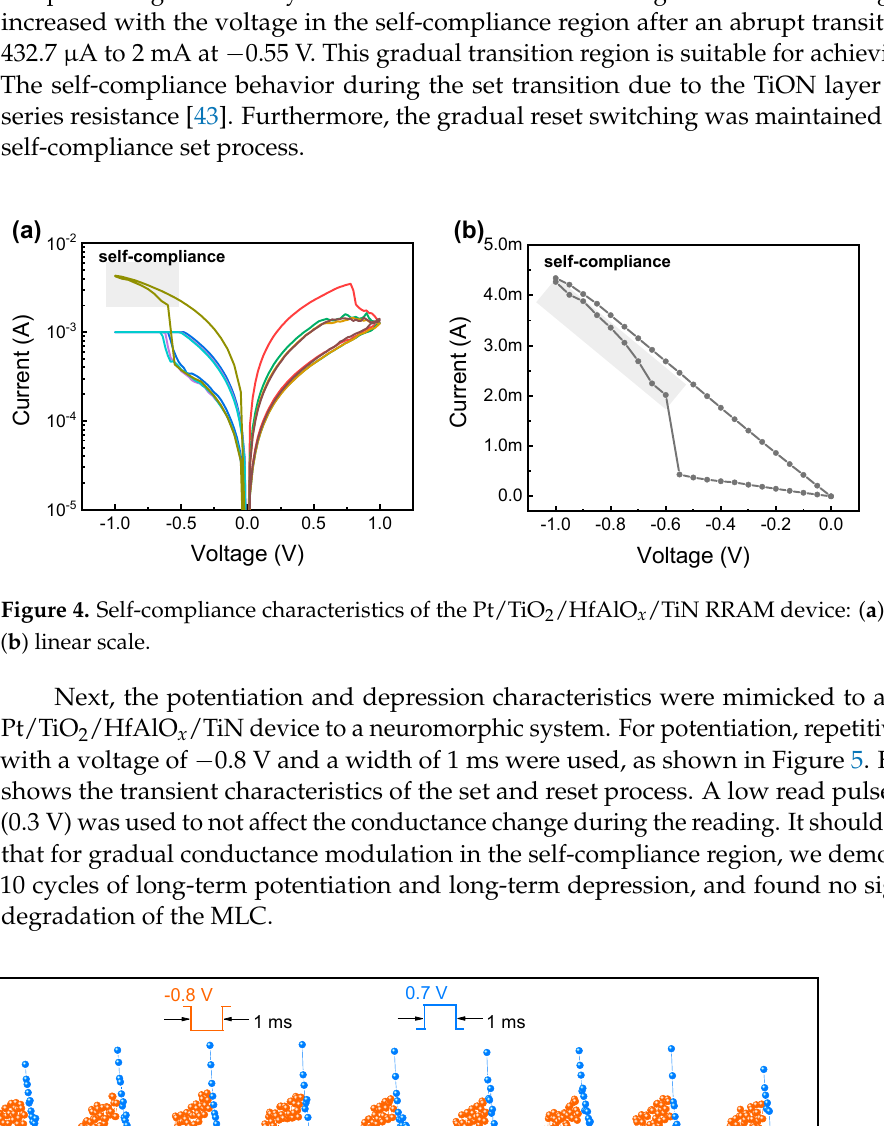
Figure 3. I–V characteristics of the Pt/TiO 2 /HfAlO x /TiN RRAM device at reset stop voltages of ( a ) 1.1 V, ( b ) 1.2 V, and ( c ) 1.3 V. ( d ) Read current distribution as a function of reset stop voltage. ( e ) MLC by reset stop voltage.